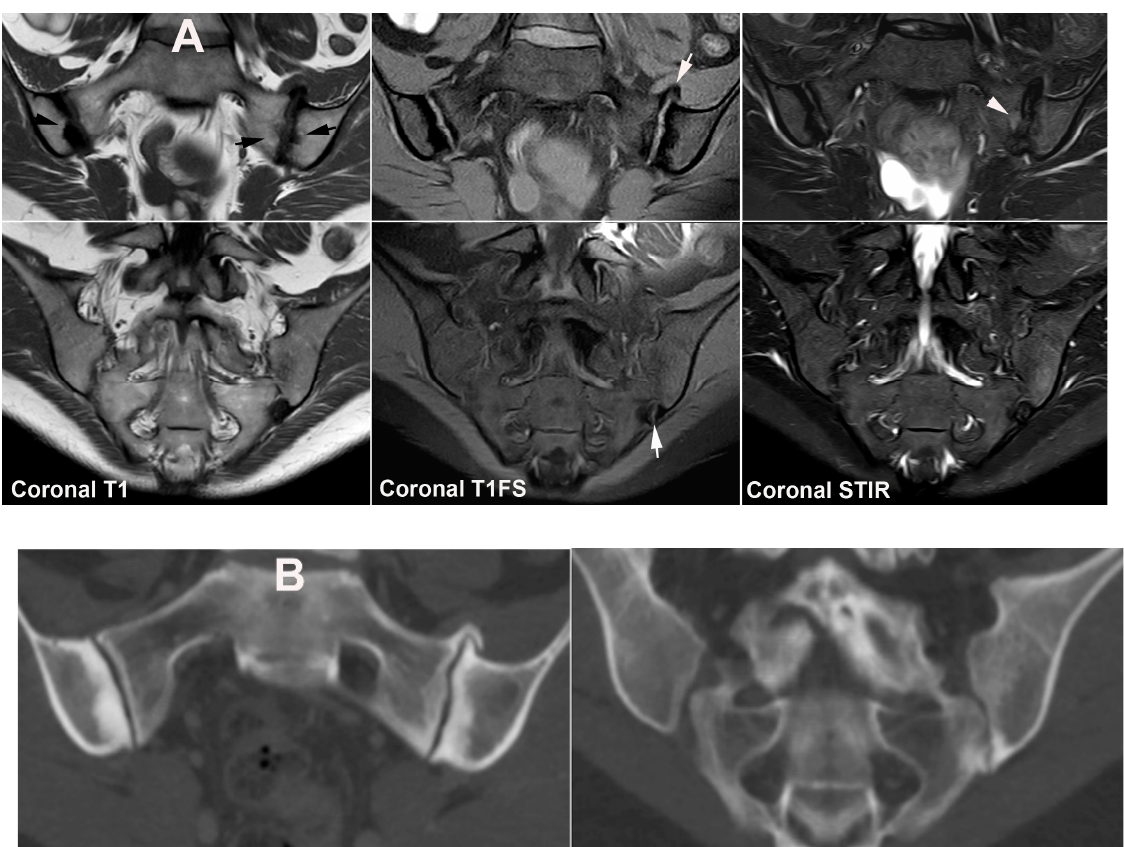
Figure 19. Degenerative SIJ changes. ( A ) MRI in a 39-year-old woman with scoliosis complaining of persistent pain with inflammatory characteristics in the region of the SIJs, especially the left SIJ, semi-coronal T1, T1FS, and STIR at the anterior part of the joint (upper image row) and posteriorly (lower image row) showing irregular joint surfaces with subchondral sclerosis anteriorly and dispersed fat deposition (black arrows on T1) in addition to osteophyte formation superiorly and inferiorly at the left SIJ (white arrows). There is also a small area of subchondral BME at the left SIJ (arrowhead). ( B ) A supplementary CT performed some months later related to scoliosis operation, semi-coronal reconstructions anteriorly and posteriorly corresponding to the MR images confirmed all degenerative changes and revealed no erosions.